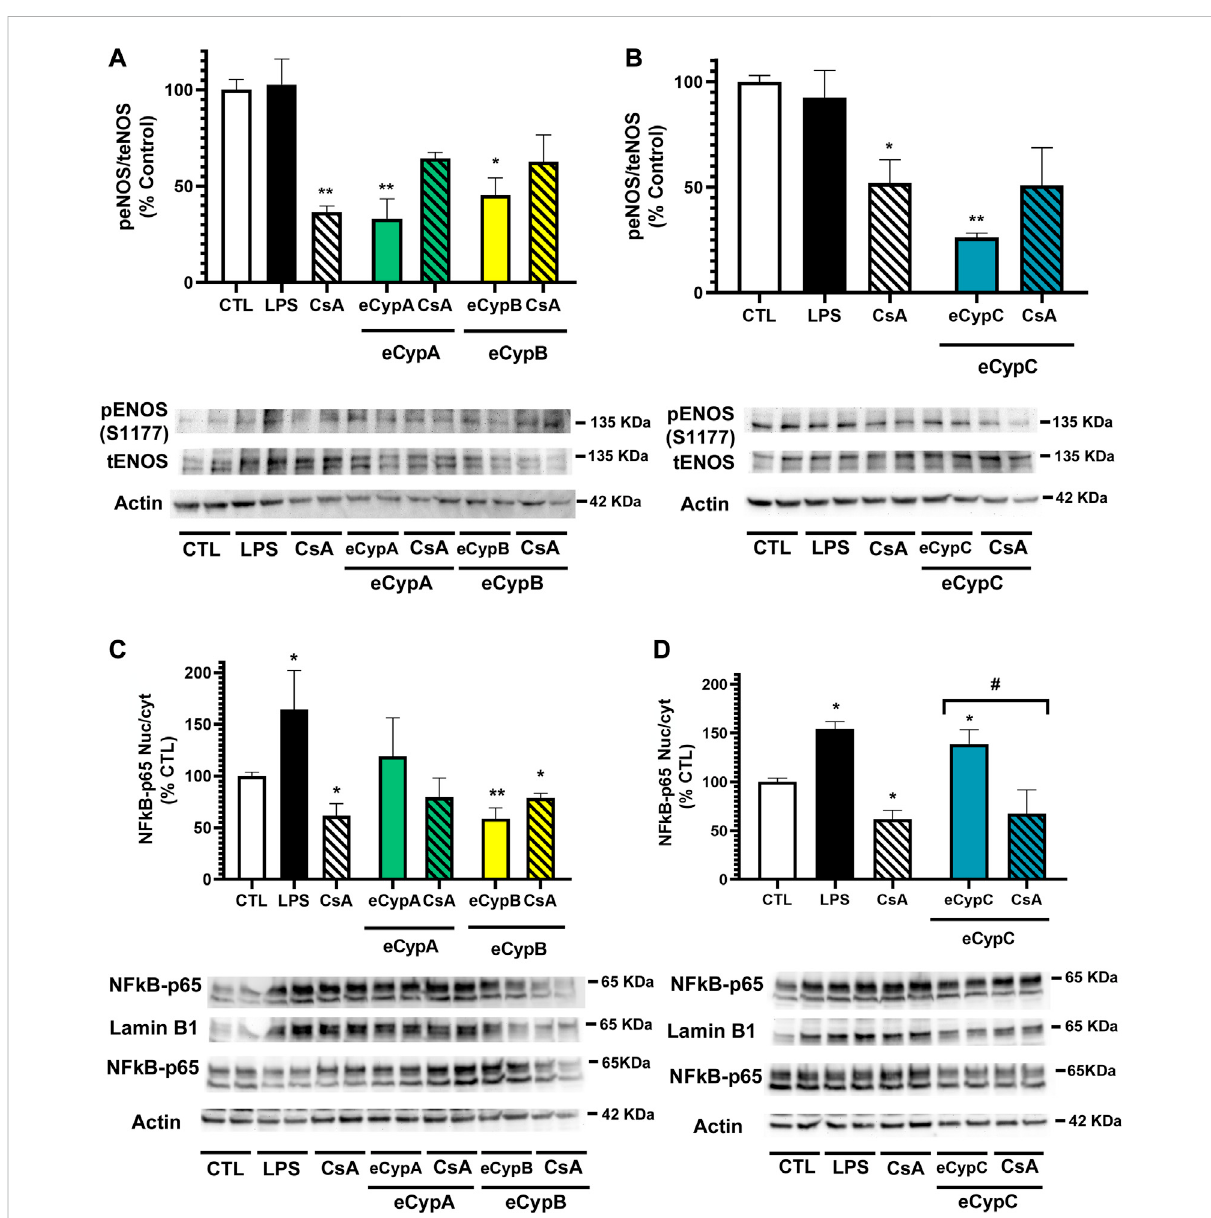
FIGURE 4 Analysis of eNOS and NFkB activation after eCyps A, B and C treatment. (A) Effect of eCypA and eCypB, (B) effect of eCypC on eNOS phosphorylation. (C) Expression levels of NFkB-p65 after eCypA, eCypB and (D) eCypC addition. Endothelial cells were pre-treated with 0.2 μ M CsA for 1 h, followed by addition of eCyps at 0.5 μ g/ml for 24 h eNOS activation was analyzed as the ratio between phosphorylated (S1177)/total protein levels.NFkBactivationwasmeasuredastheratiobetweennuclearandcytosoliclevels.ProteinbandexpressionwasnormalizedbylaminB1and actin levels in nuclear and cytosolic fractions, respectively. The quanti fi ed bands are indicated by their molecular weight. Data are mean ± SEM of three independent experiments performed by duplicate and compared by one way ANOVA and Tukey ’ s tests (** p < 0.01 compared to control cells; # p < 0.05 pairwise comparison as